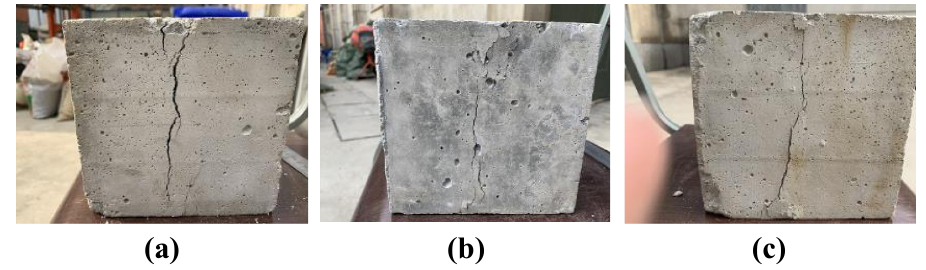
Figure 13: Failure mode of splitting tensile strength of concrete: ( a ) NC, ( b ) PSFC, and ( c ) RSFC.